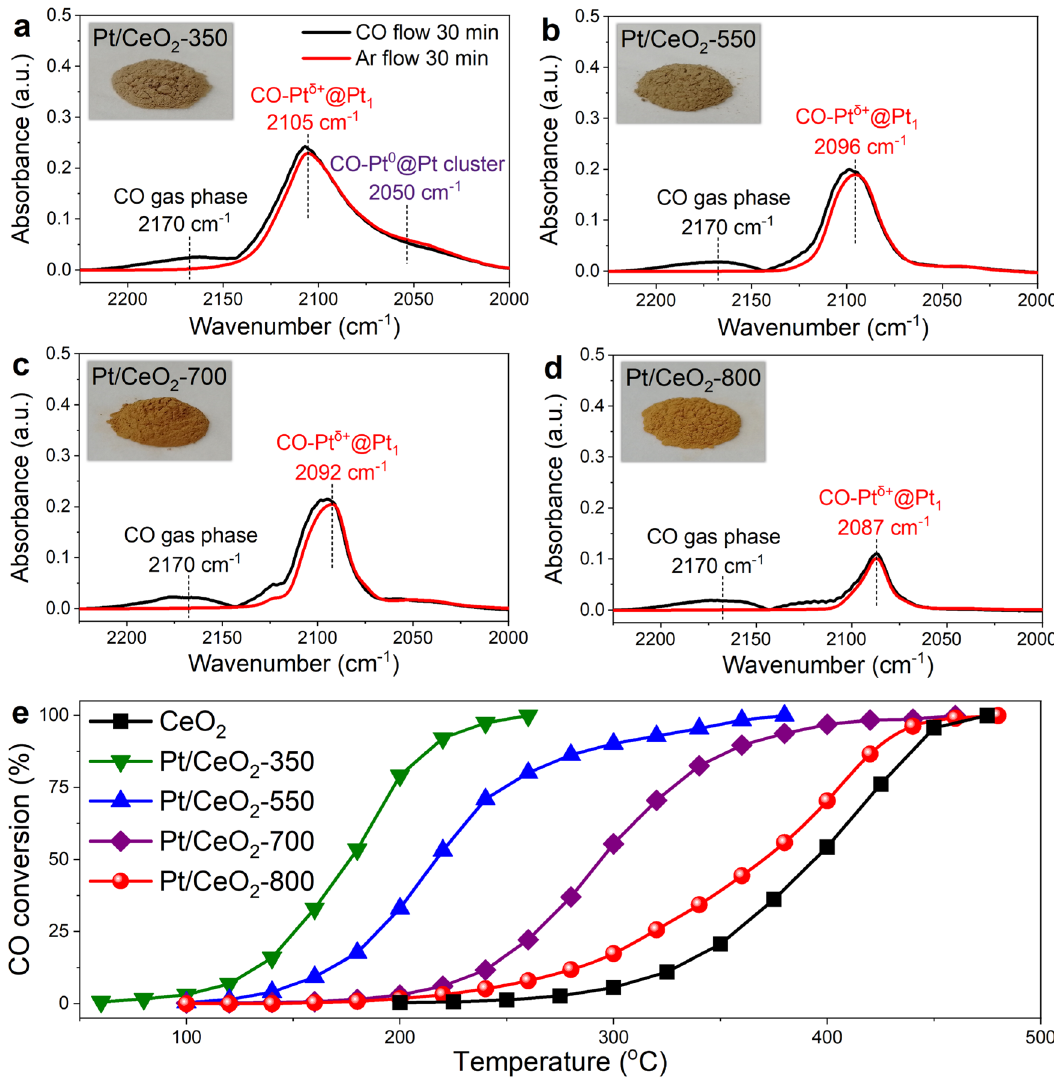
Fig.1|PtstatusdeterminedbyCOadsorptionandcorrespondingCOoxidation activity. InsituDRIFTSofCOadsorptionat25°Con a Pt/CeO 2 -350, b Pt/CeO 2 -550, c Pt/CeO 2 -700 and d Pt/CeO 2 -800 (inserted are the photos of different